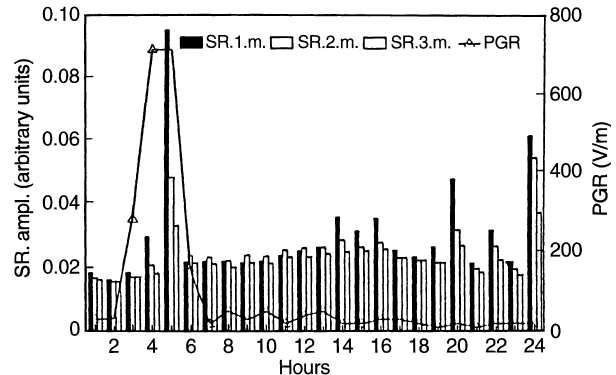
Fig. 8. Hourly relative amplitudes of the SR vertical electric component in the first three modes for a disturbed summer day (August 20, 1994) and hourly PG ranges (PGR, in V/m) for the